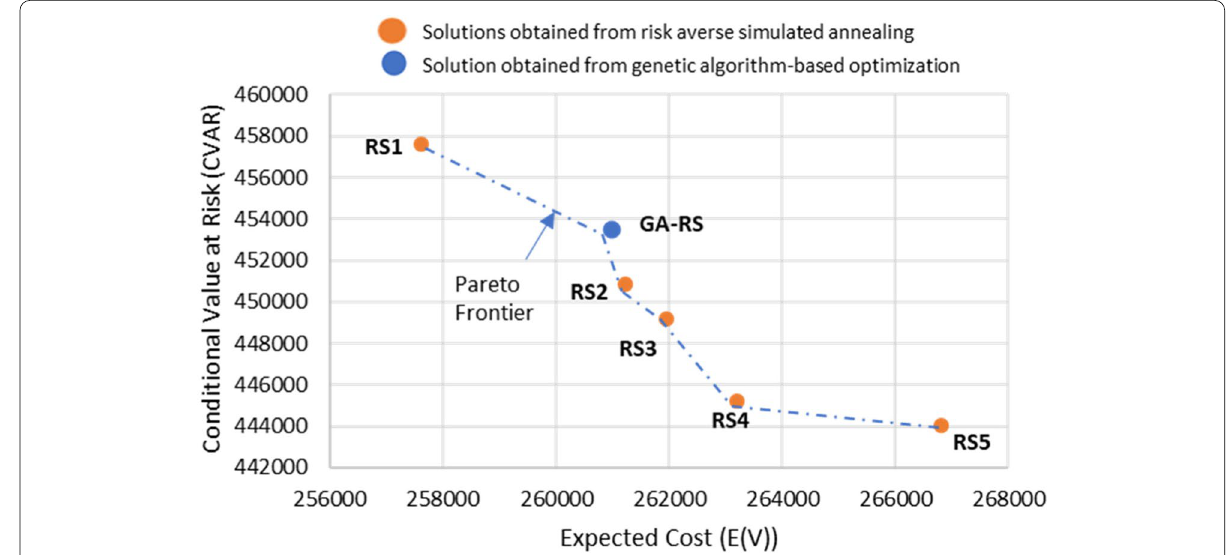
Fig. 9 Comparison of rehabilitation optimization results with and without the risk-averse